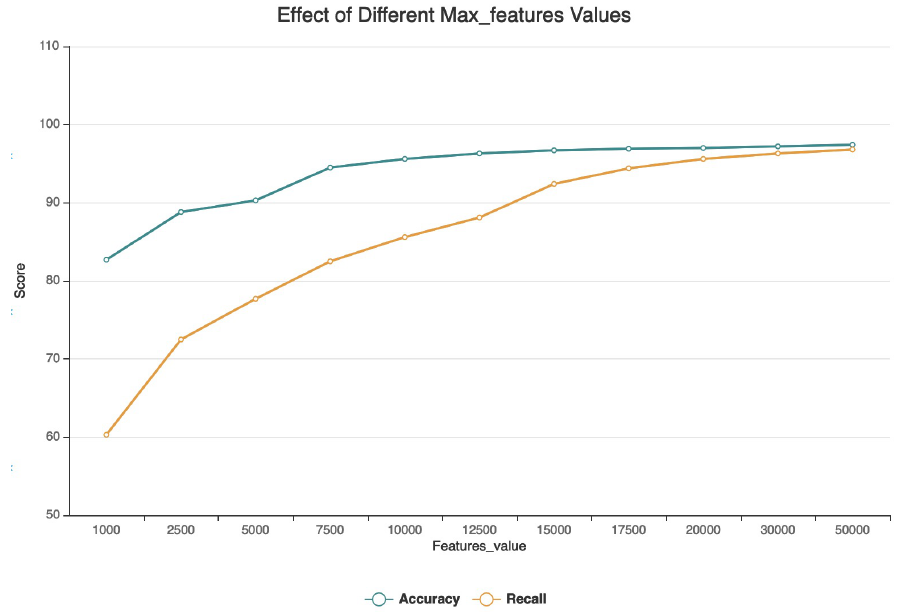
Figure 5. Impact of max_features value.